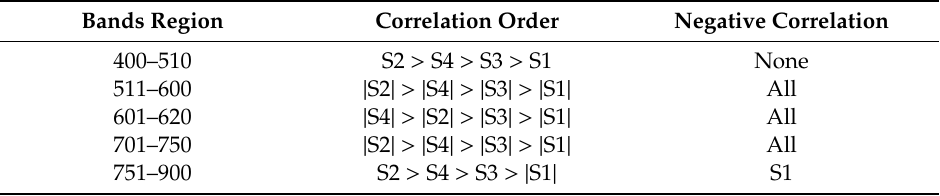
Table 3. The analysis results of correlation difference in some bands.